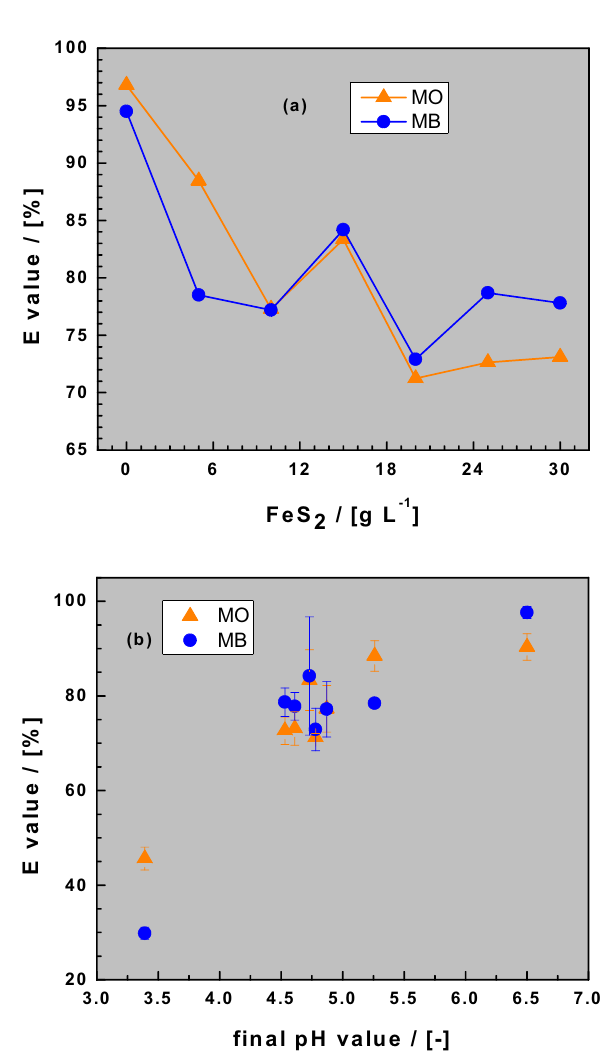
Figure 3. Changes of the dye discoloration efficiency (E values) as function of the pyrite dose ( a ) and the final pH value ( b ). Experimental conditions: V = 20 mL, m iron = 0.1 g, m sand = 0.5 g, m pyrite 0 to 0.6 g, and t = 41 d. The lines are not fitting functions, they simply connect points to facilitate